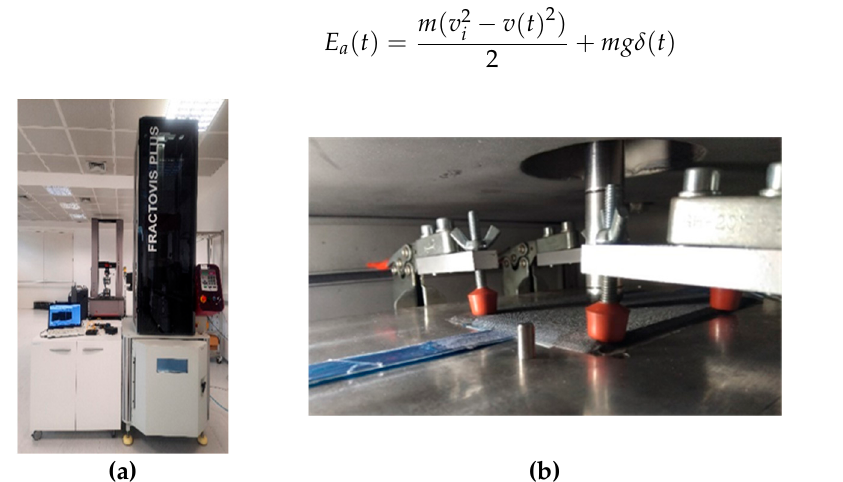
Figure 3. Drop-weight impact test setup: ( a ) OF interrogation equipment and impact testing machine; ( b ) impact support fixture with toggle clamps and impactor.